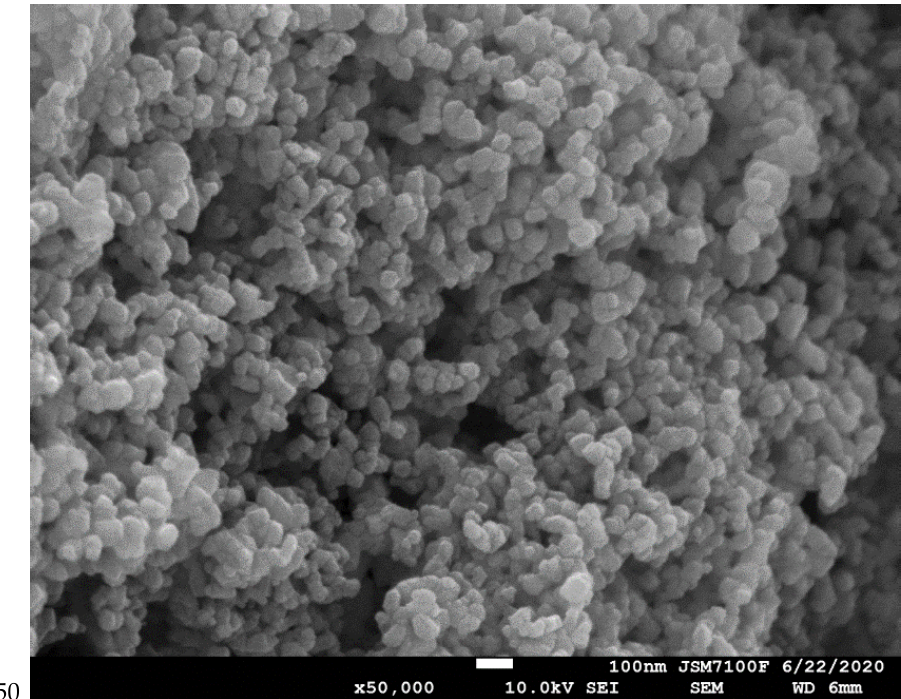
Figure 3. SEM images of the E and P samples calcined at 550, 650 and 750 °C.